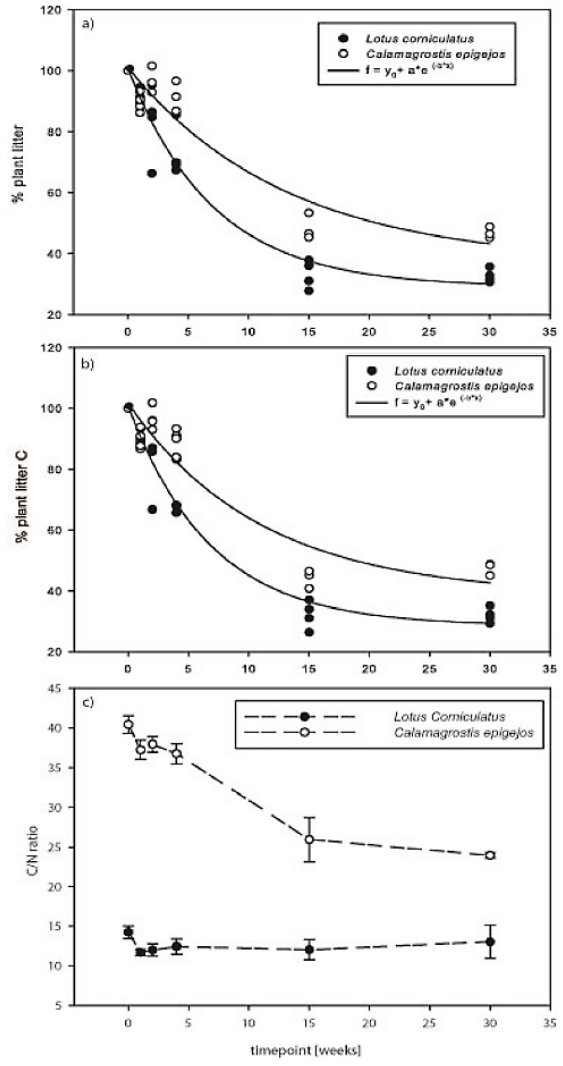
Fig. 1. Total mass loss (a) , C loss (b) and C/N ratio (c) of the plant litter throughout the experiment. Results are presented as single val- ues (a, b) or means ± standard deviation (c) based on four repli-